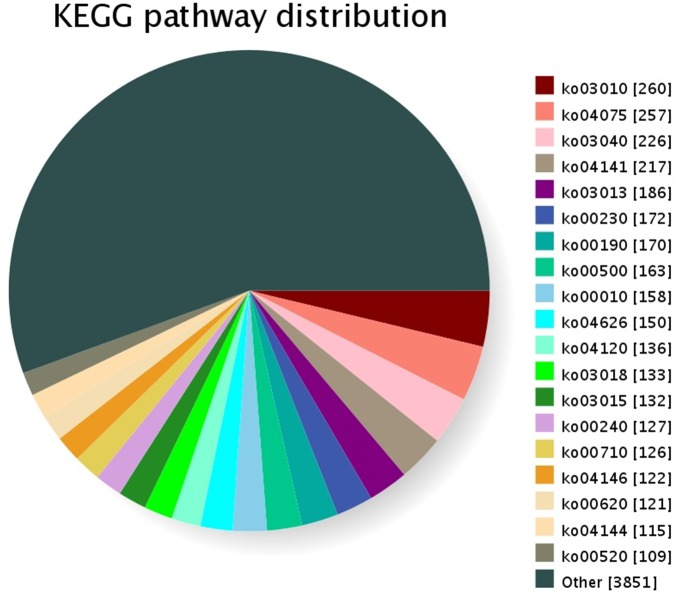
Distribution of each KEGG pathway number against the KEGG database.Each color represents a KEGG pathway. The top 19 KEGG pathways are indicated. The number of unigenes mapped in each pathway is indicated with brackets. The abbreviations represent the pathways as follows: ko03010: Ribosome; ko04075: Plant hormone signal transduction; ko03040: Spliceosome; ko04141: Protein processing in endoplasmic reticulum; ko03013: RNA transport; ko00230: Purine metabolism; ko00190: Oxidative phosphorylation; ko00500: Starch and sucrose metabolism; ko00010: Glycolysis/Gluconeogenesis; ko04626: Plant-pathogen interaction; ko04120: Ubiquitin mediated proteolysis; ko03018: RNA degradation; ko03015: mRNA surveillance pathway; ko00240: Pyrimidine metabolism; ko00710: Carbon fixation in photosynthetic organisms; ko04146: Peroxisome; ko00620: Pyruvate metabolism; ko04144: Endocytosis; ko00520: Amino sugar and nucleotide sugar metabolism.